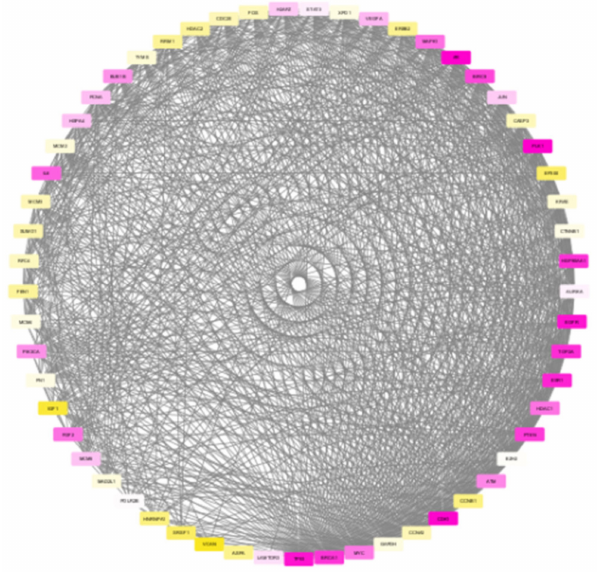
Figure 6. Degree-based view of the TNBC module generated by Cytoscape showing higher connec- tivity among the